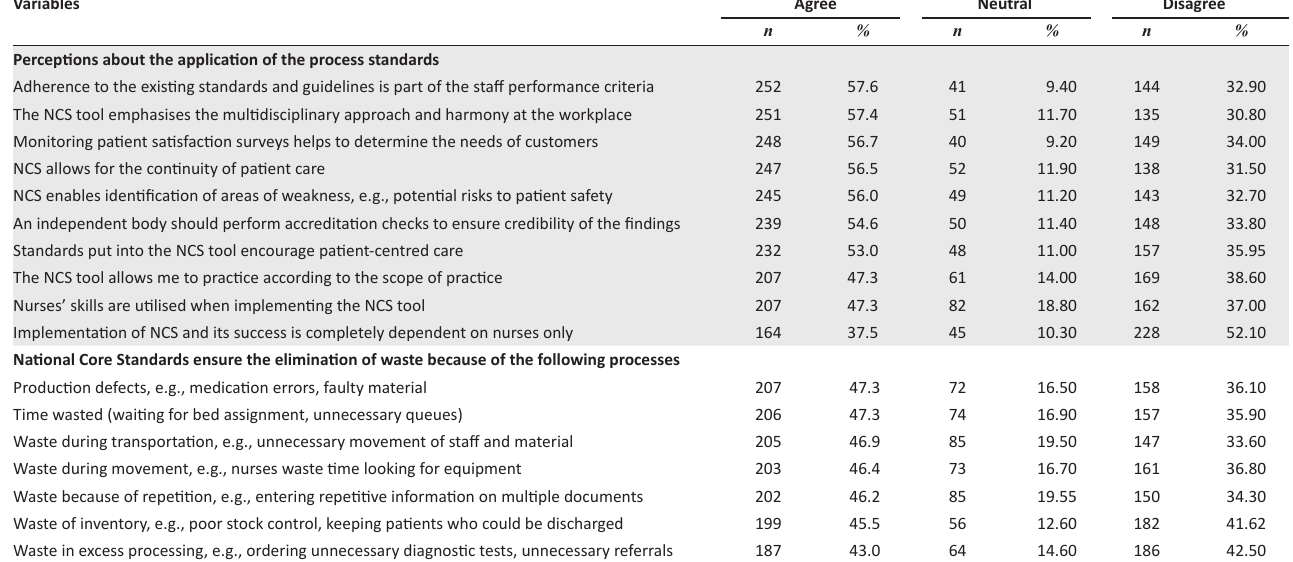
TABLE 4: Nurses’ perceptions about the application of process standards of the National Core Standards tool.